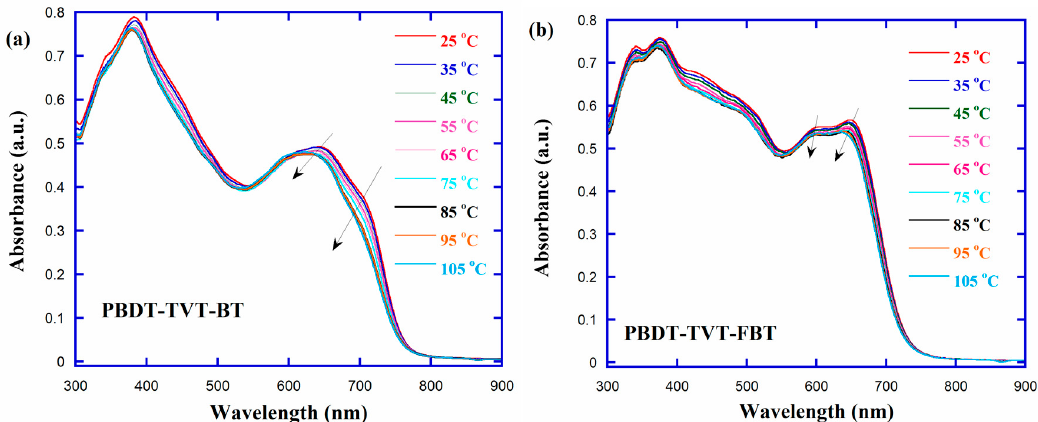
Figure 3. Temperature-dependent absorption (TD-Abs) spectra for the highly conjugated copolymers ( a ) PBDT-TVT-BT and ( b ) PBDT-TVT-FBT.